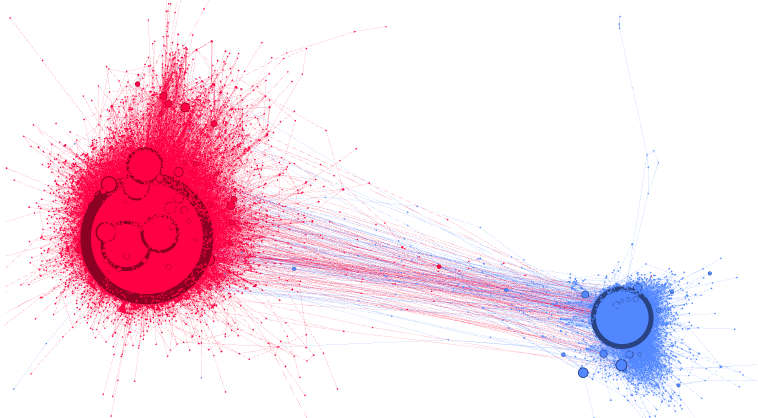
Figure 1. The Red (anti-White Helmets) and Blue (pro-White Helmets) clusters in the White Helmets conversation on Twitter. Analyzing the English-language White Helmets conversation on Twitter (see Methods), we detected two distinct “clusters” or sub-networks of accounts that share information with each other through retweets (Figure 1): one cluster that was highly critical of the White Helmets (the anti-White Helmets cluster, red, on the left) and another cluster that was predominantly supportive of the group (the pro-White Helmets cluster, blue, on the